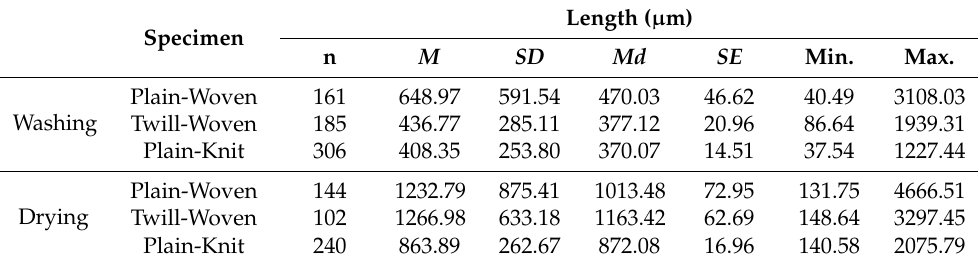
Figure 7. Frequency distribution diagram of the length of the microplastics. ( a ) Microplastic length distribution from washing. ( b ) Microplastic length distribution from drying. Table 2. Descriptive statistics of the length of the released microplastic